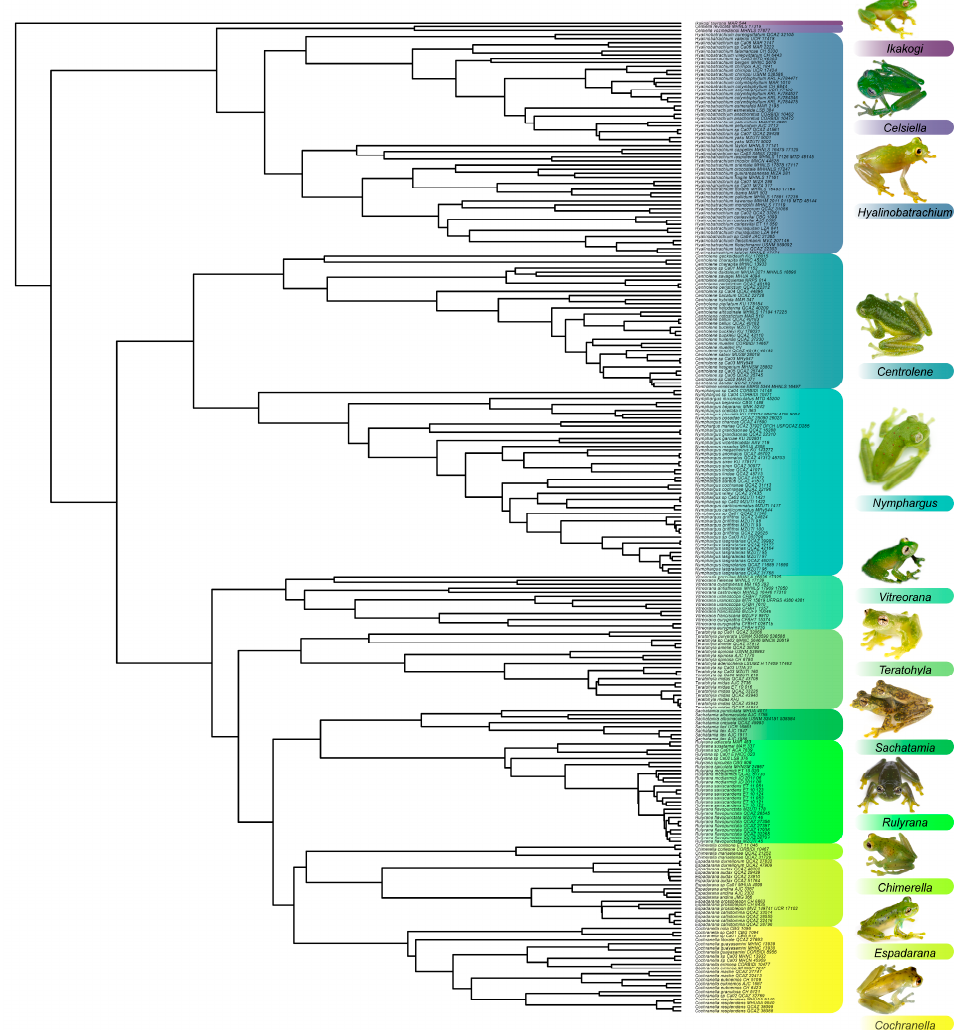
Figure 1. Relationships among glassfrog genera as inferred herein, using maximum likelihood criterium. Taxonomy sensu Guayasamin et al. [1]. Taxon sampling includes 113 named glassfrog species, 24 putative new species, and 49 outgroup taxa (not shown). The dataset contains complete or partial sequences of 10 genes representing 6513 bp of data (mitochondrial: 12S rRNA, 16S rRNA, ND1; in previous studies, as well as this one (see Table S2). Relationships within each genus are shown in additional figures and follow the same